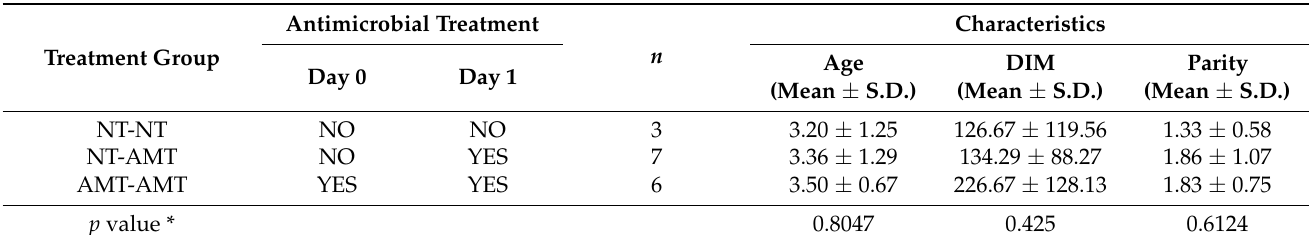
Table 2. The use of antimicrobial agents in each treatment group and cow characteristics enrolled in this study.